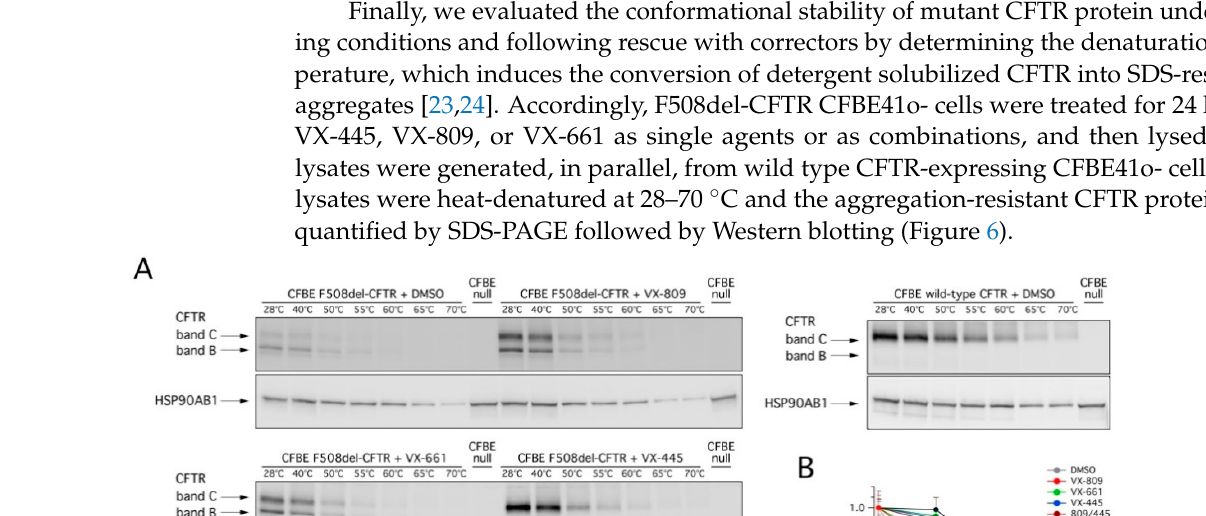
For each time-point, symbols indicate statistical significance vs. the indicated condition: *, p < 0.05; **, p < 0.01; ***, p < 0.001; ns = not significant.